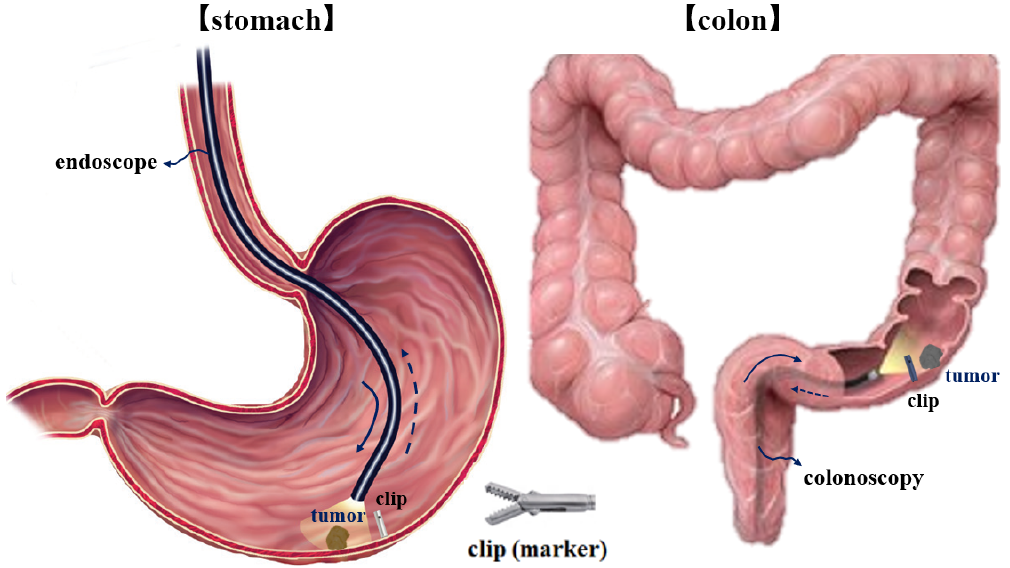
Figure 13. Process of clip installation in mucosa in stomach and colon using endoscope and colono- scope, respectively.